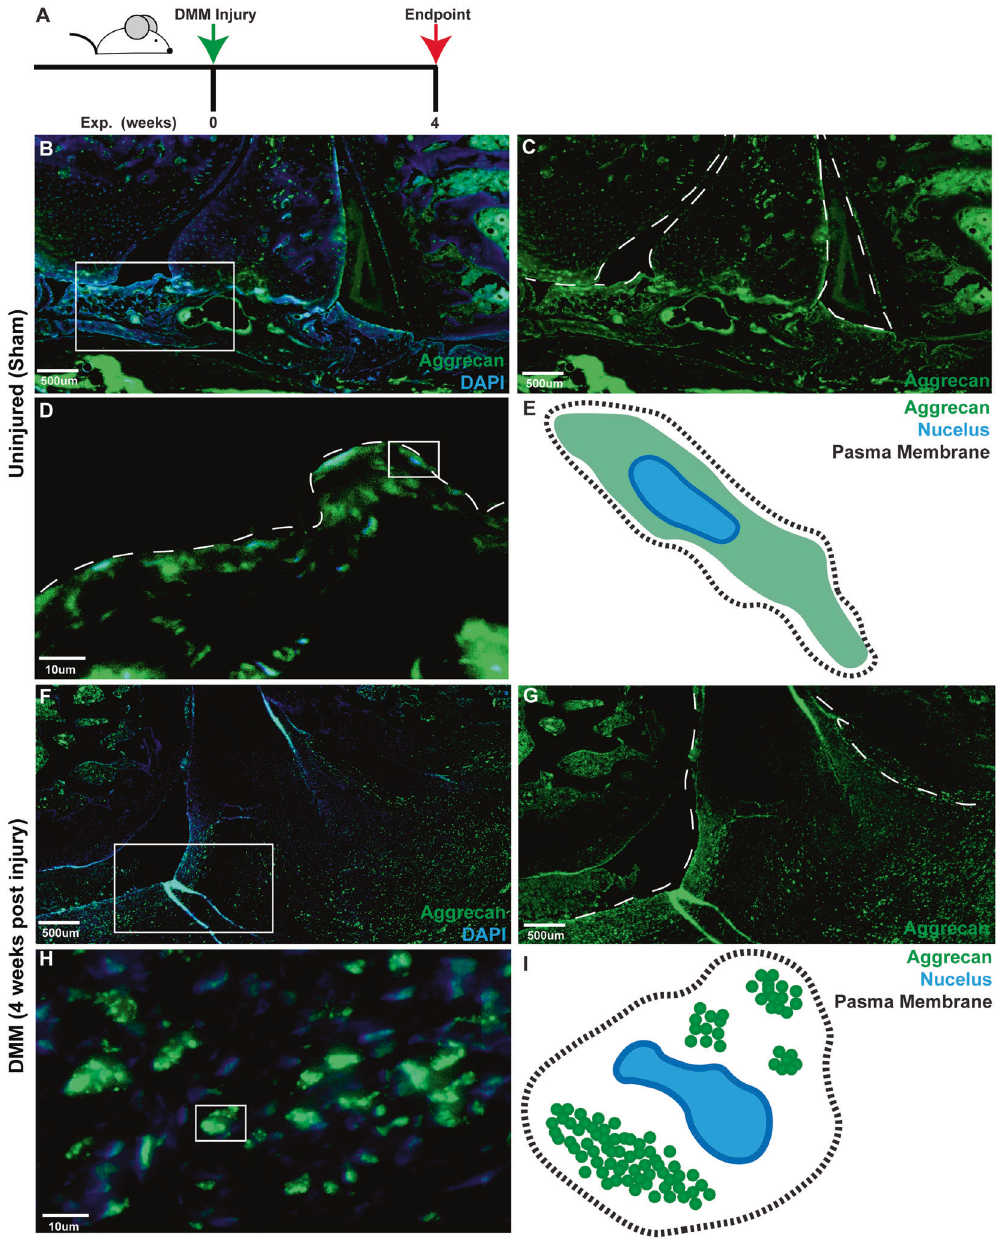
Fig. 5 Aggrecan staining in rat synovium. Normal ( n = 5) and DMM induced OA ( n = 5) rat joints ( A ) were stained with aggrecan and DAPI. In normal synovium aggrecan staining was observed within the intimal and the sub-intimal ( B , C ) layers and was diffuse throughout the cell ( D diagrammatic representation E ). In OA synovium, aggrecan staining was throughout the intima and sub-intima ( F , G ). In OA synovium a punctate pattern of staining was observed in the synovium ( H diagrammatic representation I